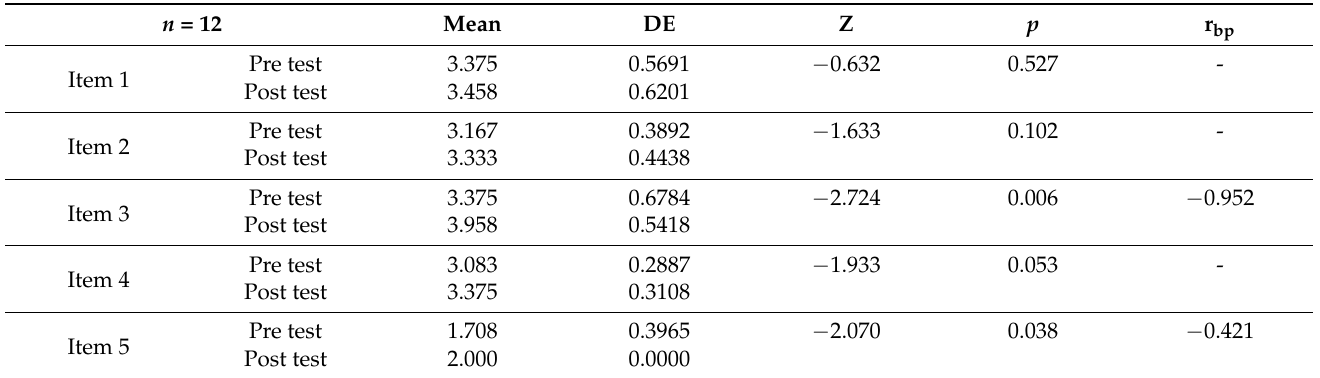
Table 2. A comparison of the rating of each grade sheet item before and after using IVR.